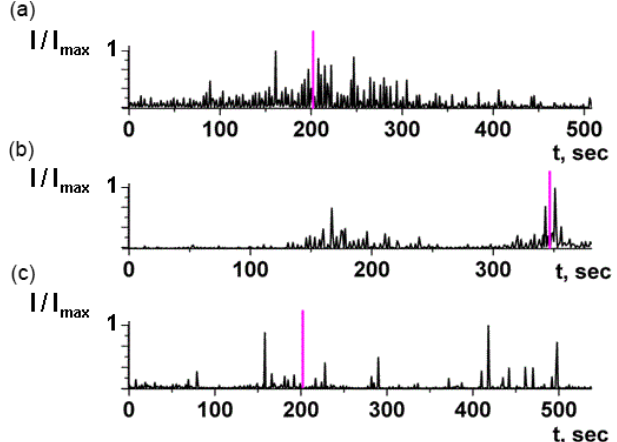
Figure 9. The time distributions of the intensities of VLF range sig- nals registered on board the DEMETER satellite, normalized to the corresponding maximum values: (a) and (b) after the acoustic dis- turbance, and (c) without the acoustic disturbance. The beginning of the acoustic radiation was chosen at a moment of time 10min before the moment of time corresponding to the minimum distance from the satellite to the point of the acoustic generation. The ver- tical arrow of each plot is the moment of the minimum distance from the satellite to the point of the acoustic generation (Lviv). Panel (a) shows satellite flight over artificial acoustically disturbed zone (200s), (b) shows satellite flight over Vrancea earthquake zone (Romania) first (130–210s) and then over artificial acoustically dis- turbed zone (320–380s), and (c) shows satellite flight over the point of the acoustic radiator location when generation is absent